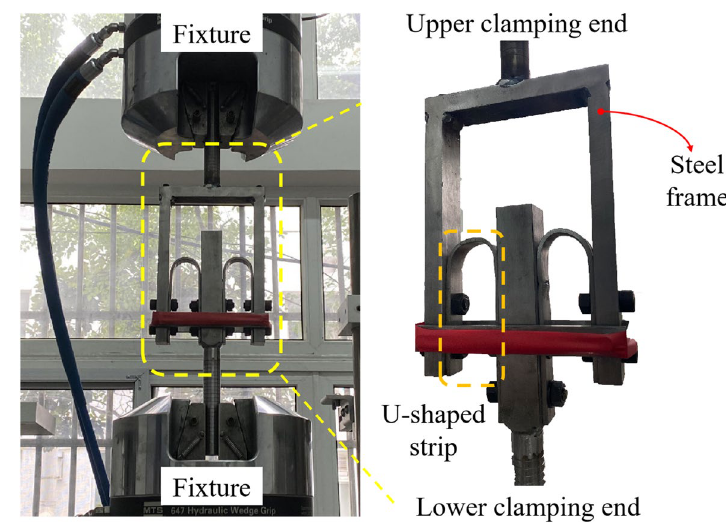
Fig. 8 Test setup for USS and specially‑designed steel frame